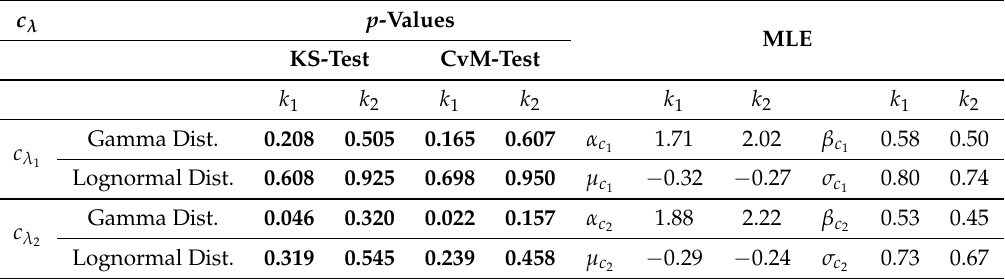
Table 3. Parameters and p -values for c λ